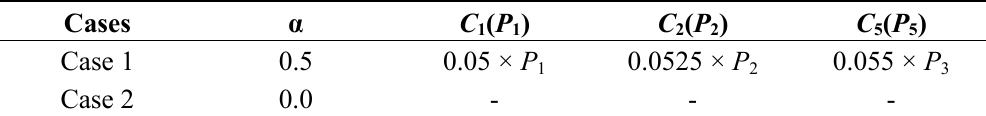
Table 3. Cost parameters for simulation.